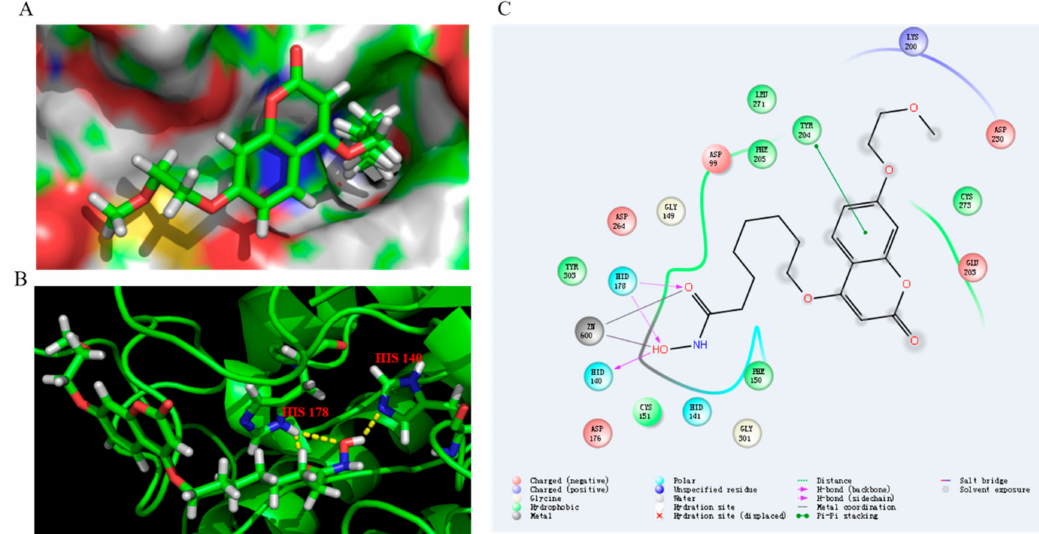
Figure 8. Proposed binding mode of compound 13c with HDAC1 (PDB 4BKX). ( A ) Molecular surface of the HDAC1 binding pocket with 13c . ( B ) 13c interacted with the active site of HDAC1. ( C ) The 2D interaction diagrams of compound 13c with